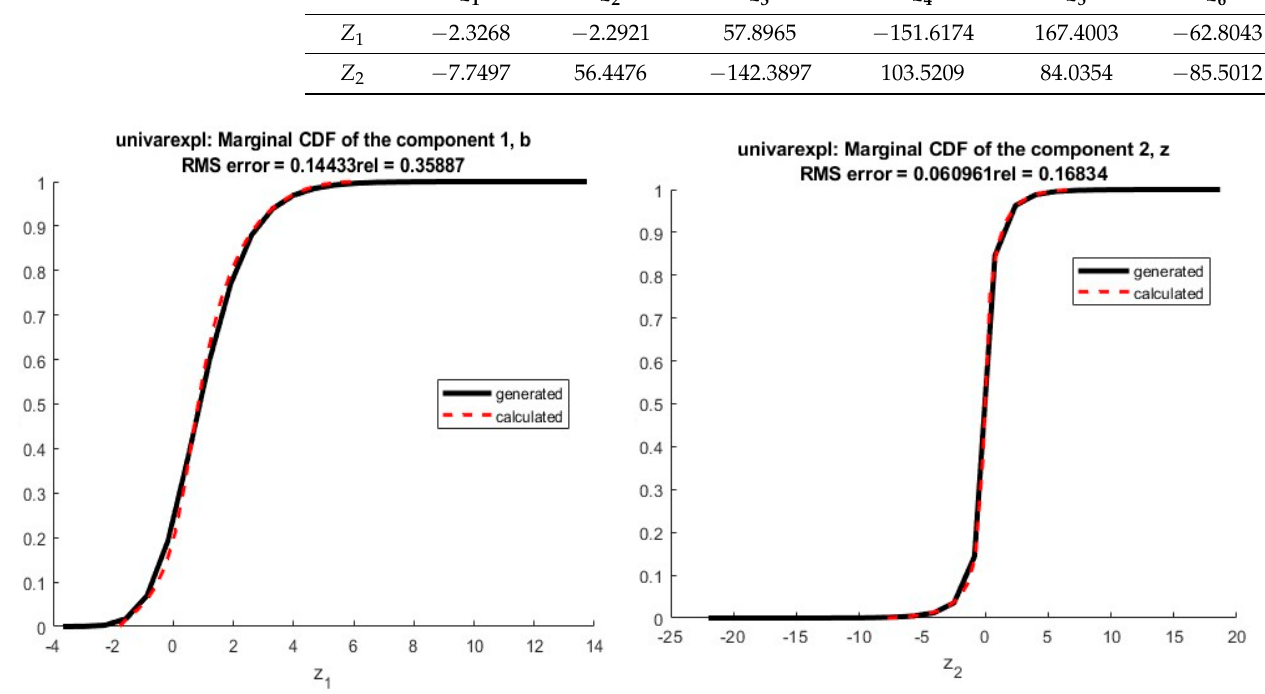
Figure 4. Cumulative density function obtained by MM in the first example.